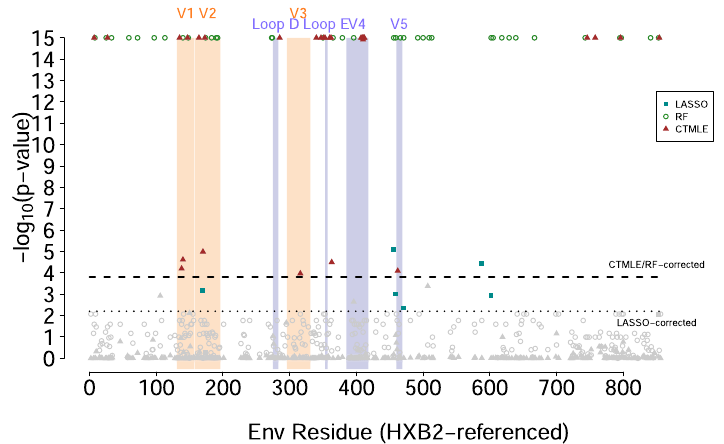
Figure 6: Results for the VRC01 antibody based on three approaches: LASSO, random forests ( RF ) , and CTMLE. The dashed lines indicate thresholds from a Bonferroni - correction to compensate multiple